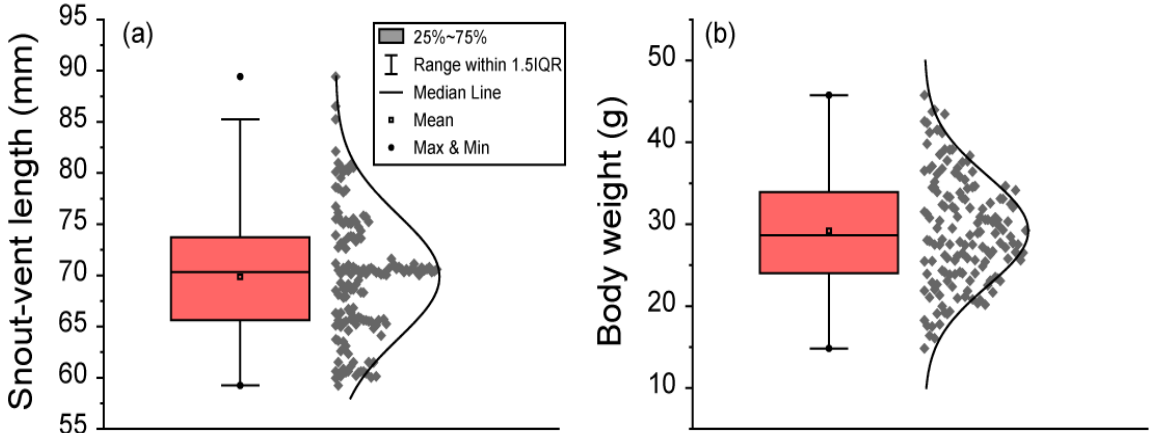
Figure 2. The body length and body weight of 151 male black-spotted pond frogs: ( a ) the snout–vent length (SVL) in frogs; ( b ) frog body weight. Box plots show the mean (central square point), median (central band), minimum (bottom dot), maximum (top dot), 25th and 75th percentiles (bottom and top of boxes), and range within the 1.5 interquartile range (IQR).